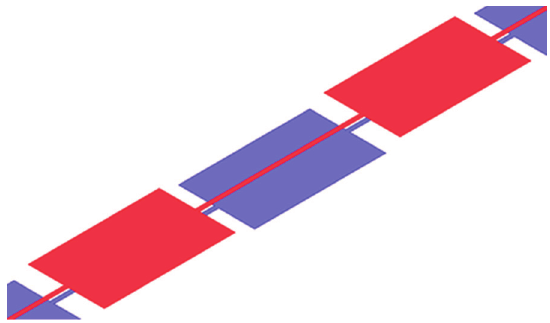
Figure 2. Structure of the proposed antenna model with a ground layer and a feed layer.